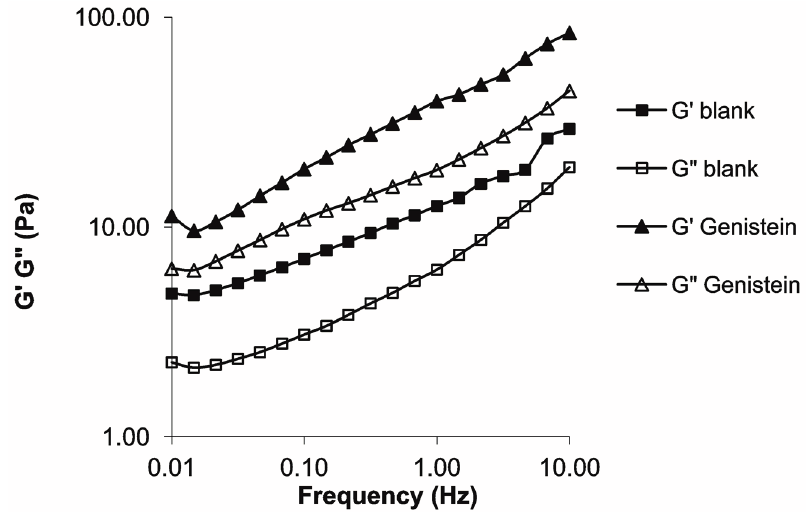
Figure 2. Rheological characterization of the blank and Genistein (Gen)-containing LLC formulations. Melanoma was induced and the formulation was applied as indicated in the Experimental Section.